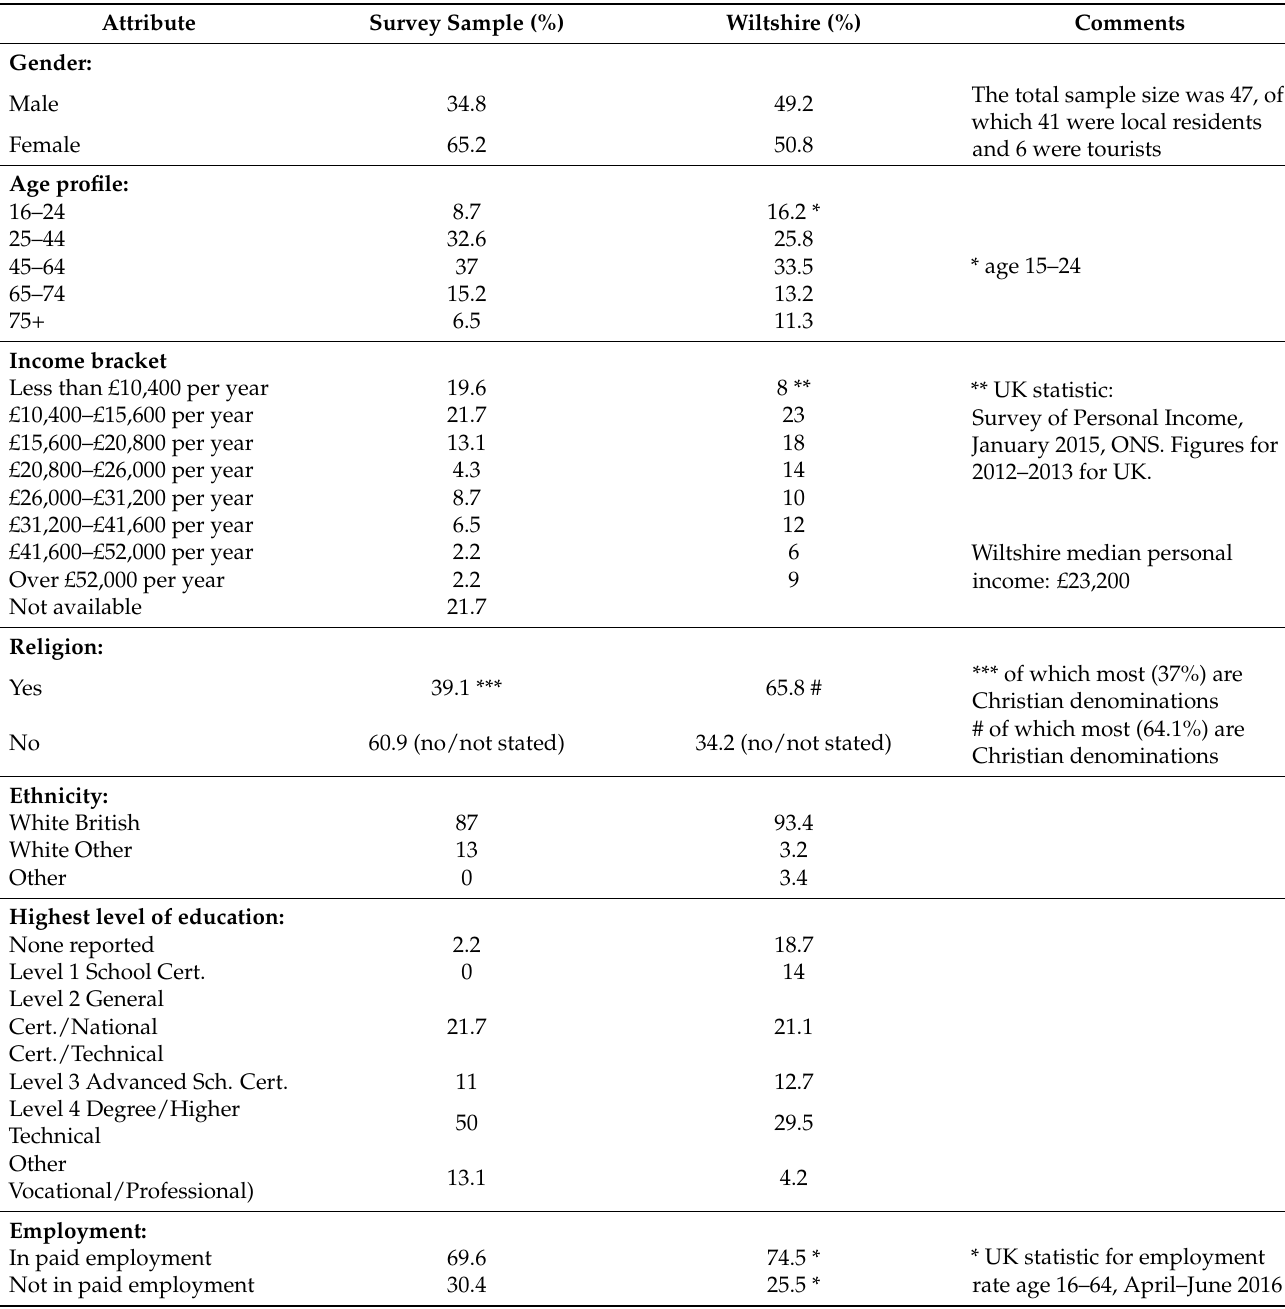
Table A1. Demographic Background of